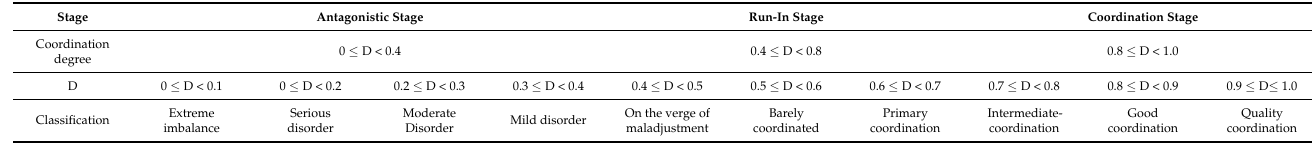
Table 2. Classification of coordination